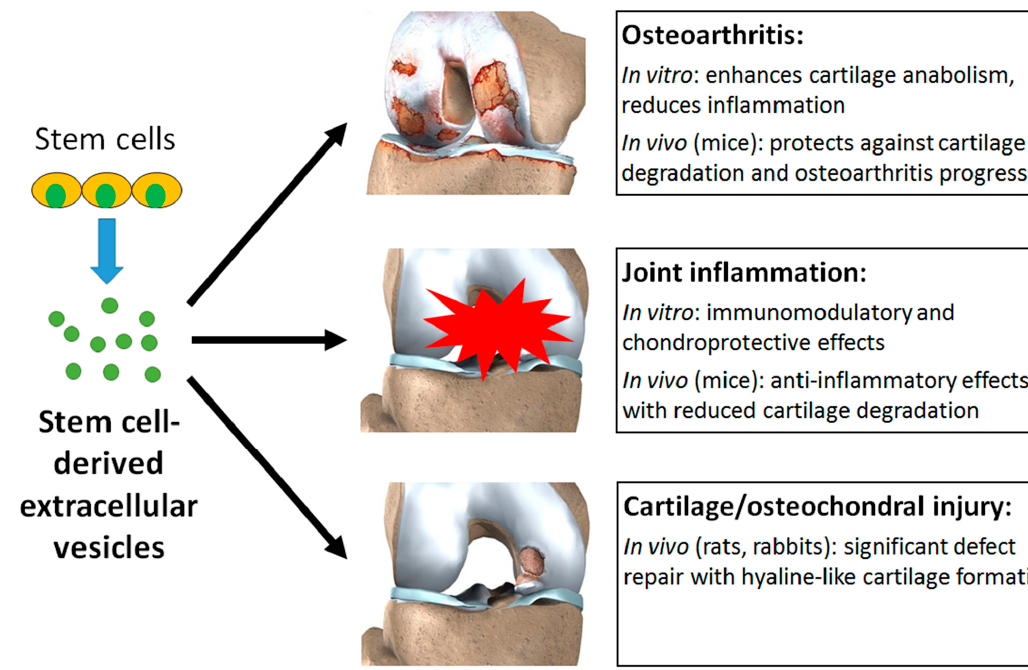
Figure 4. Stem cell-derived EVs can exert a multitude of beneficial effects in experimental models of osteoarthritis, joint inflammation, and cartilage or osteochondral injury.